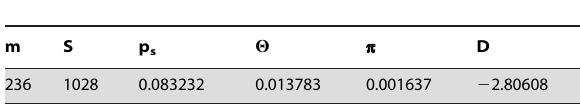
Table 2. Results from Tajima’s Neutrality